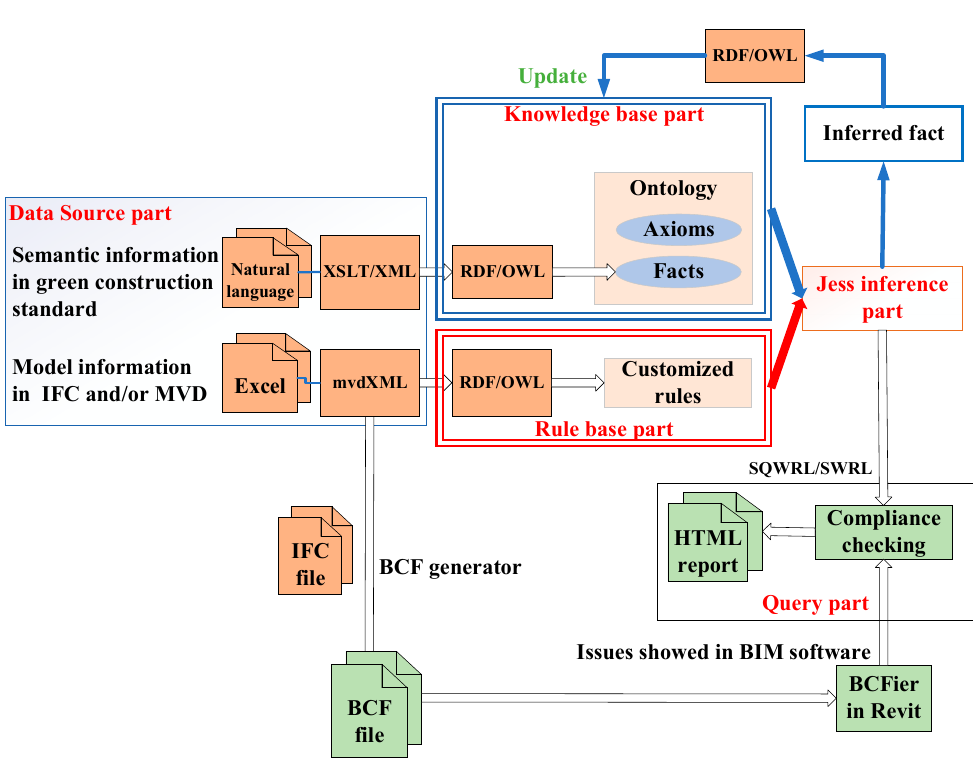
Figure 2. Workflow of code checking.